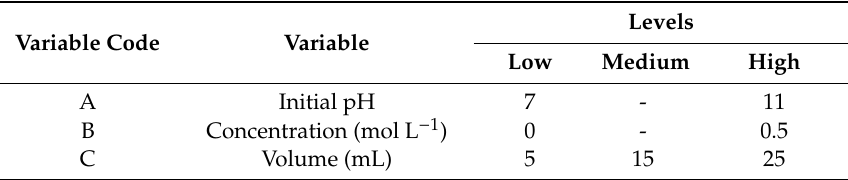
Table 1. Process variables and their